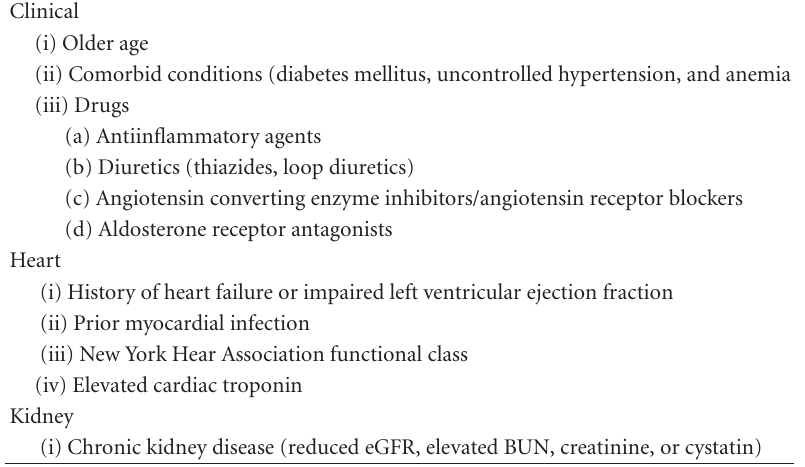
Table 1: Risk factors for the cardiorenal syndrome [1].